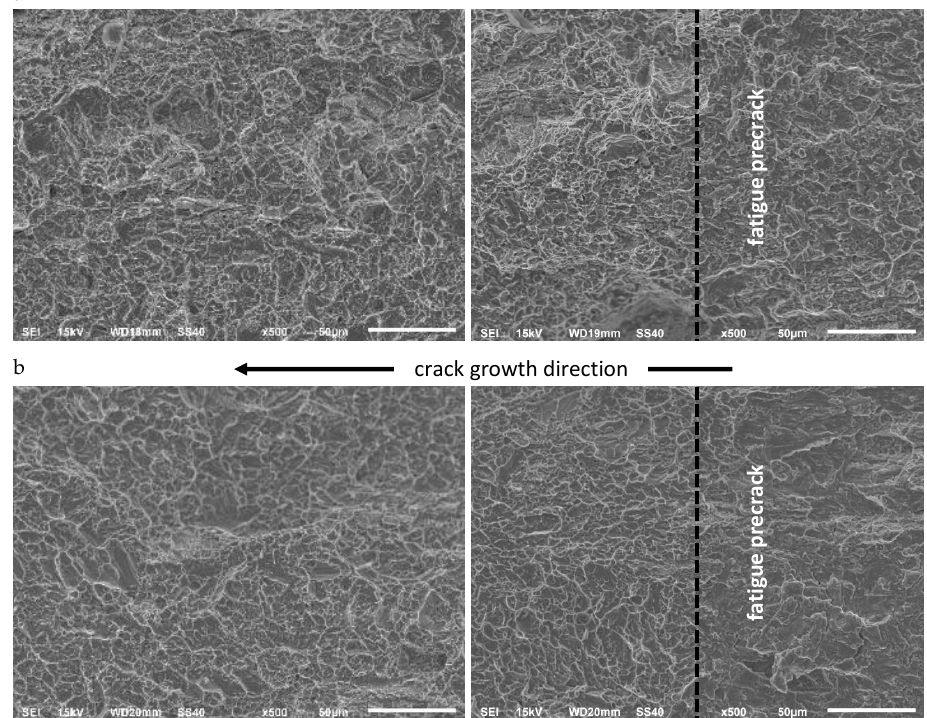
Figure 13. A comparison of Ti6Al4V layer in CT specimens made of Al–Ti laminate at 293 K ( a ), at 77 K ( b ).